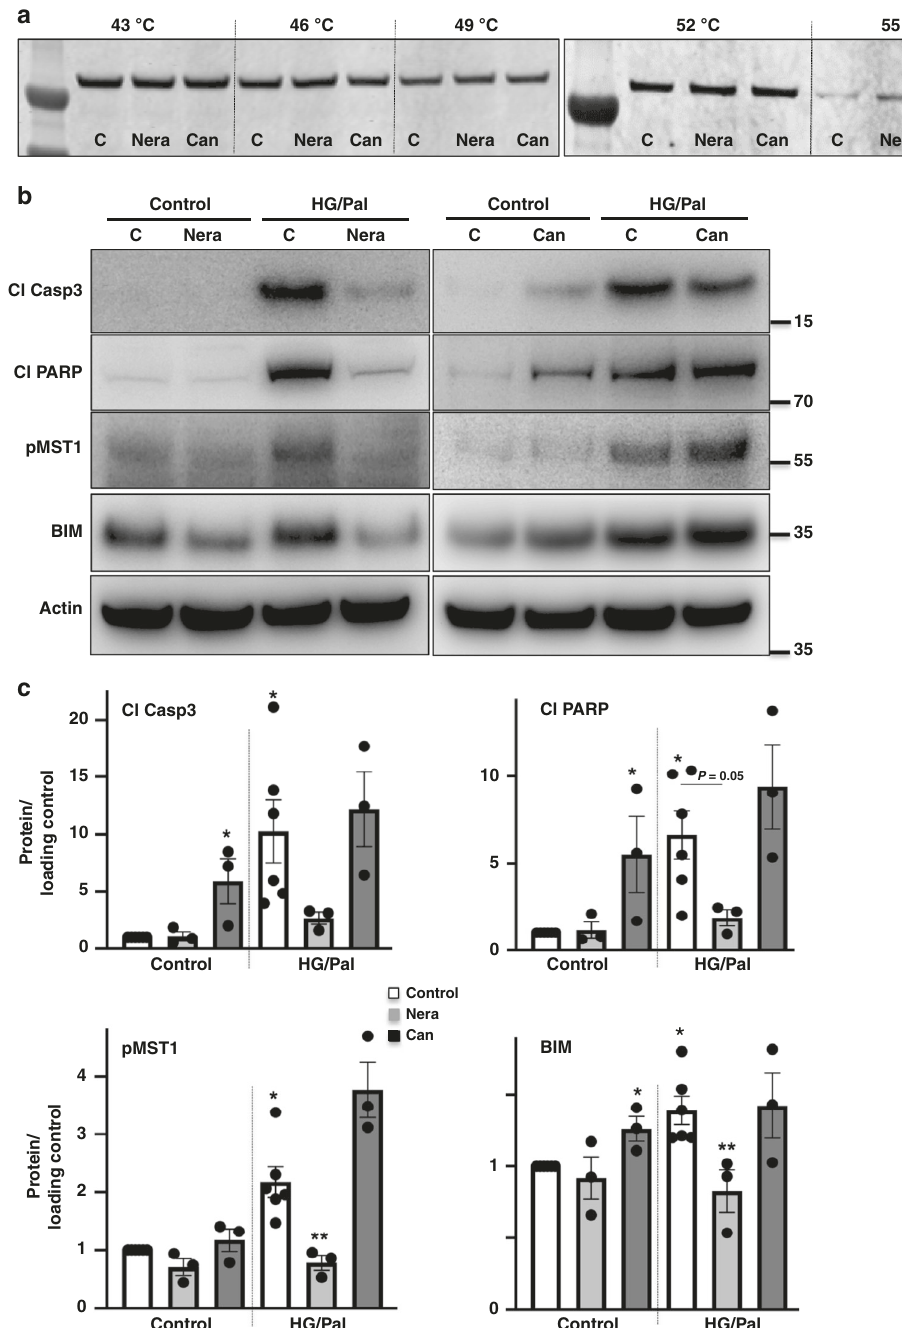
Fig. 5 Neratinib but not canertinib binds to MST1 and restores β -cell survival through MST1 inhibition. a CETSA assay was performed in INS-1E cells pretreated with 5 μ M neratinib, canertinib, or vehicle control, followed by heating to denature and precipitate protein at different temperatures. The stabilized MST1 protein in the soluble fraction of the cell lysate was detected by using western blotting. b , c INS1-E cells were exposed to diabetogenic conditions (22.2 mM glucose and 0.5 mM palmitate (HG/Pal)) ± 10 μ M neratinib or canertinib for 24 h. Phospho-MST1 (pMST1; pThr183), caspase-3 and PARP cleavage, and BIM and actin were analyzed by western blotting. Representative Western blots ( b ) and pooled quantitative densitometry analysis ( c ) are shown from 3 – 6 independent culture dishes ( n = 3 – 6). Results shown are means ± SEM. * p < 0.05 HG/Pal to control, ** p < 0.05 neratinib to vehicle + HG/Pal-treated β -cells under the same conditions; all by Student ’ s t tests. Source data are provided as a Source Data fi three important markers for β -cell glucose metabolism and Many cells within the islets, which still express insulin, had lost insulin production — the transcription factors PDX1 and NKX6.1 their NKX6.1 expression. These effects were markedly attenuated and the glucose transporter Glut2. MLD – STZ-treated mice by neratinib treatment (Fig. 7a, b). The PDX1 target gene Glut2 showed impairment in the islet architecture with smaller islets was largely preserved in β -cell membranes of control mice, while and many insulin-negative cells together with reduced numbers the disrupted islet architecture of diabetic mice was also apparent and expression of nuclear PDX1- and NKX6.1-positive cells. by Glut2 staining, which was barely detectable in the MLD – STZ-